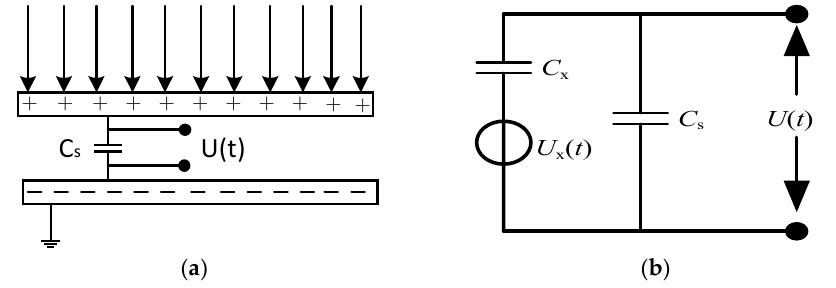
Figure 12. Schematic diagram of the electric field sensor. ( a ) Electric field sensor structure schematic; ( b ) equivalent circuit diagram of the electric field sensor.